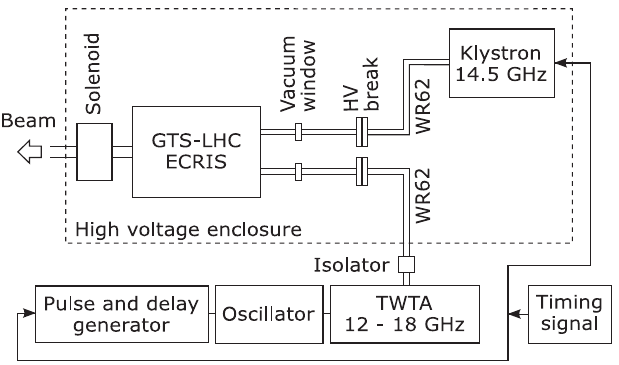
FIG. 3. A schematic presentation of the measurement setup used in the double frequency heating experiments.